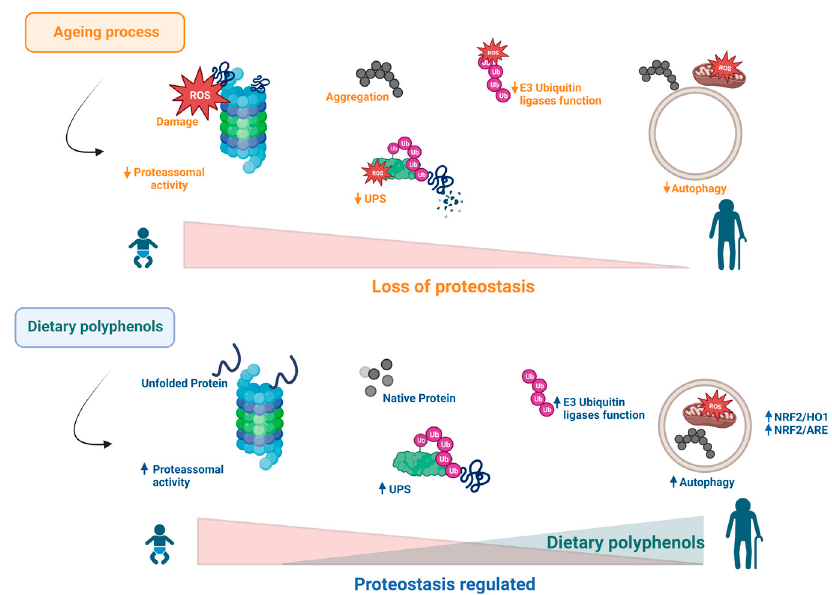
Figure 4. During ageing, the increase in ROS affects proteasomal and autophagy processes. Conse- quently, proteostasis is lost, as shown by the detrimental accumulation of protein aggregates and damaged organelles such as mitochondria. Several reports have been shown that dietary polyphenols can reverse the deleterious effects associated with this hallmark of ageing.